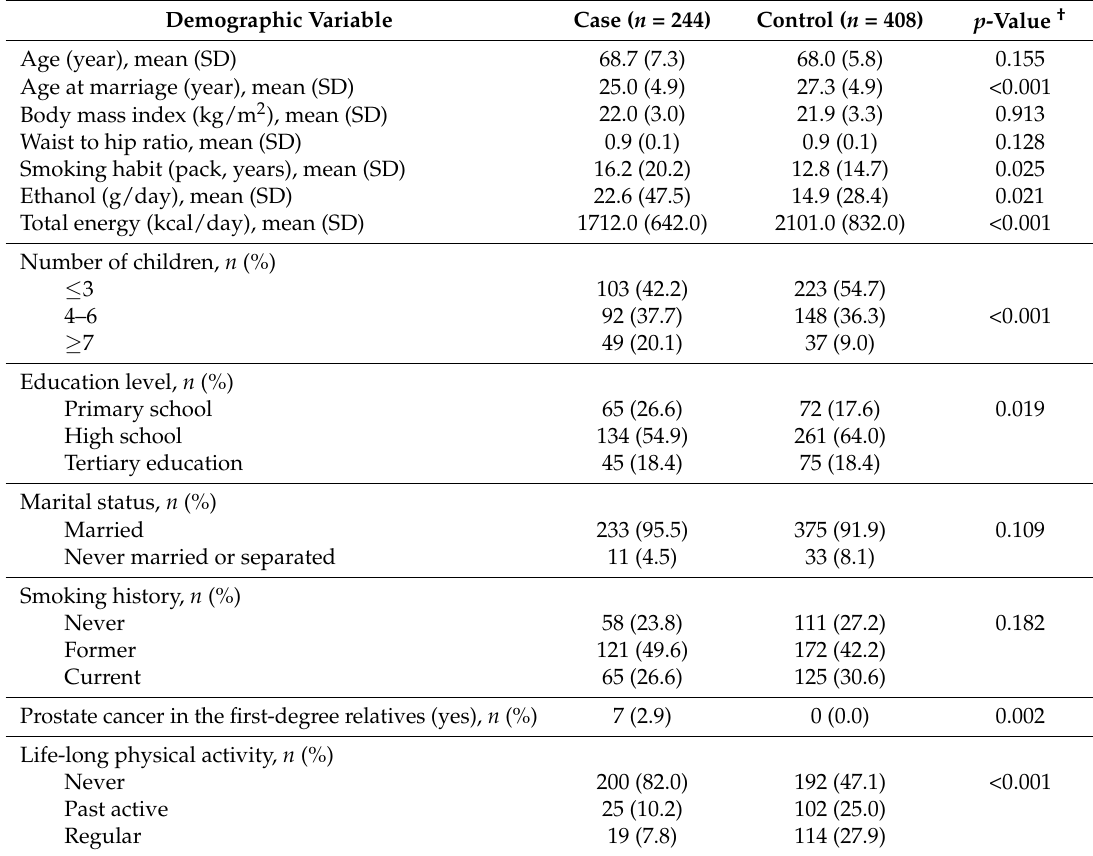
Table 1. Sample characteristics.